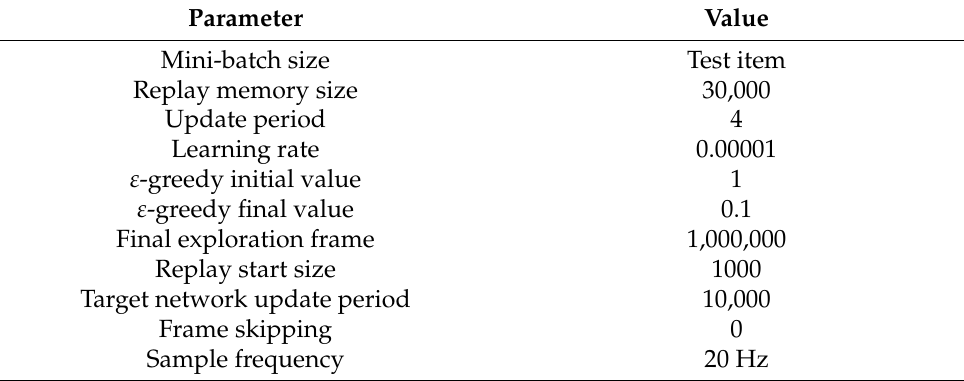
Table 11. The parameters for testing sample Mini-batch size.